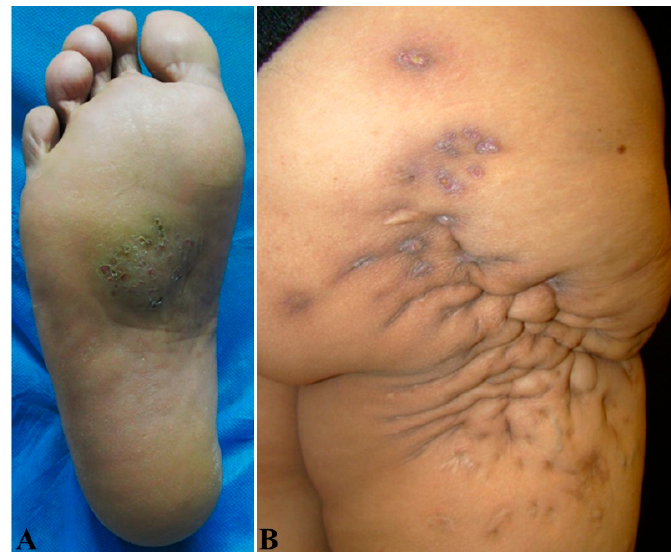
Figure 2. Clinical presentation of actinomycetoma. ( A ) A raised, swelling actinomycetoma with multiple sinuses and yellow discharges on the surface of the middle sole caused by Nocardia brasiliensis with an evolution of 7 years in a 43-year-old male patient. ( B ) Multiple, different-staged actinomycetomas on the disfigured gluteus and outer side of the right thigh caused by Nocardia brasiliensis with an evolution of 12 years in a 54-year-old female patient. Courtesy of Dr. Jesus Dante Guerra.